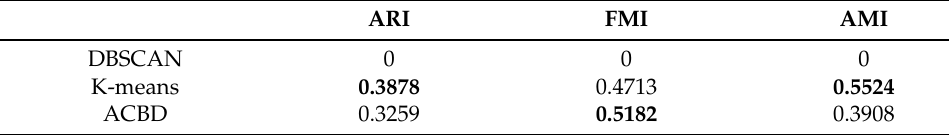
Table 4. Comparison of HAPT experimental